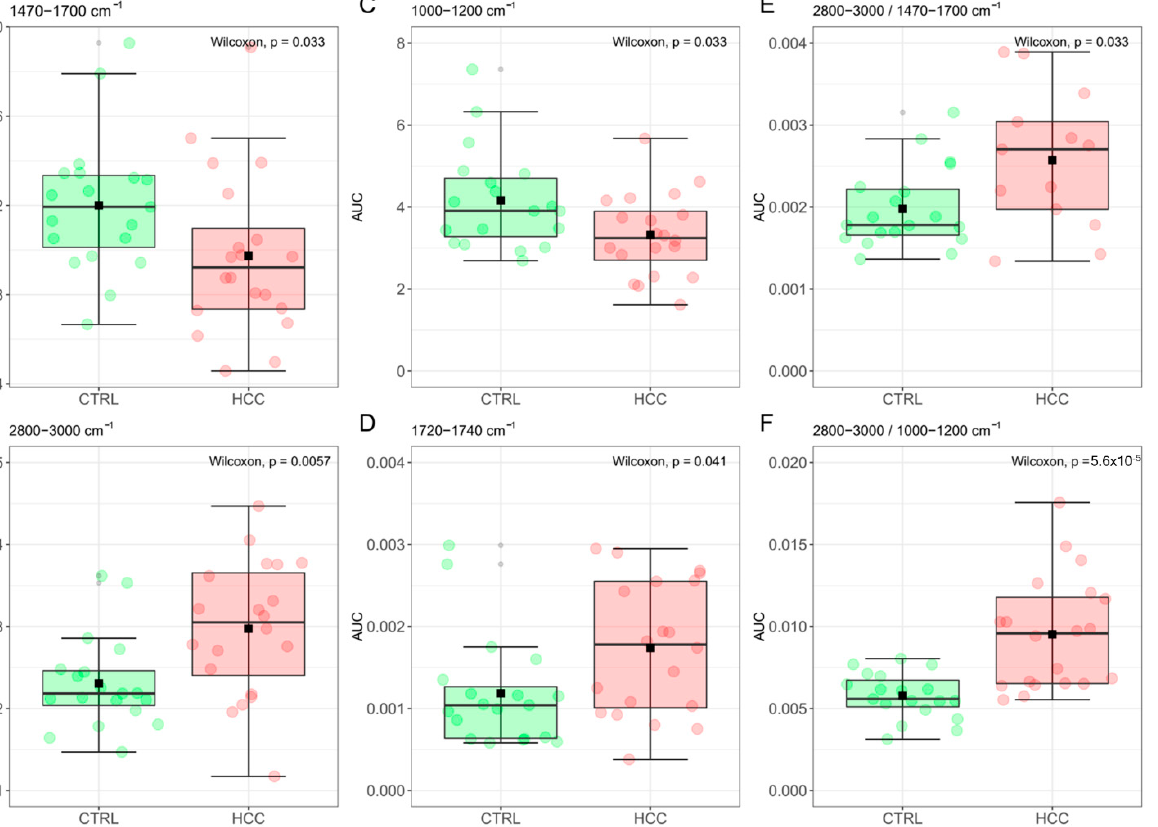
Figure 4. Box-plot analysis of areas computed for the amide I and II bands at 1470–1700 cm − 1 ( A ), the lipid CH stretching band at 2800–3000 cm − 1 ( B ), the carbohydrates and nucleic acids band at 1000–1200 cm − 1 ( C ), and the C=O stretching band at 1720–1740 cm − 1 ( D ). The ratio between the integrated area computed in panels B and A ( E ) and B and C ( F ).